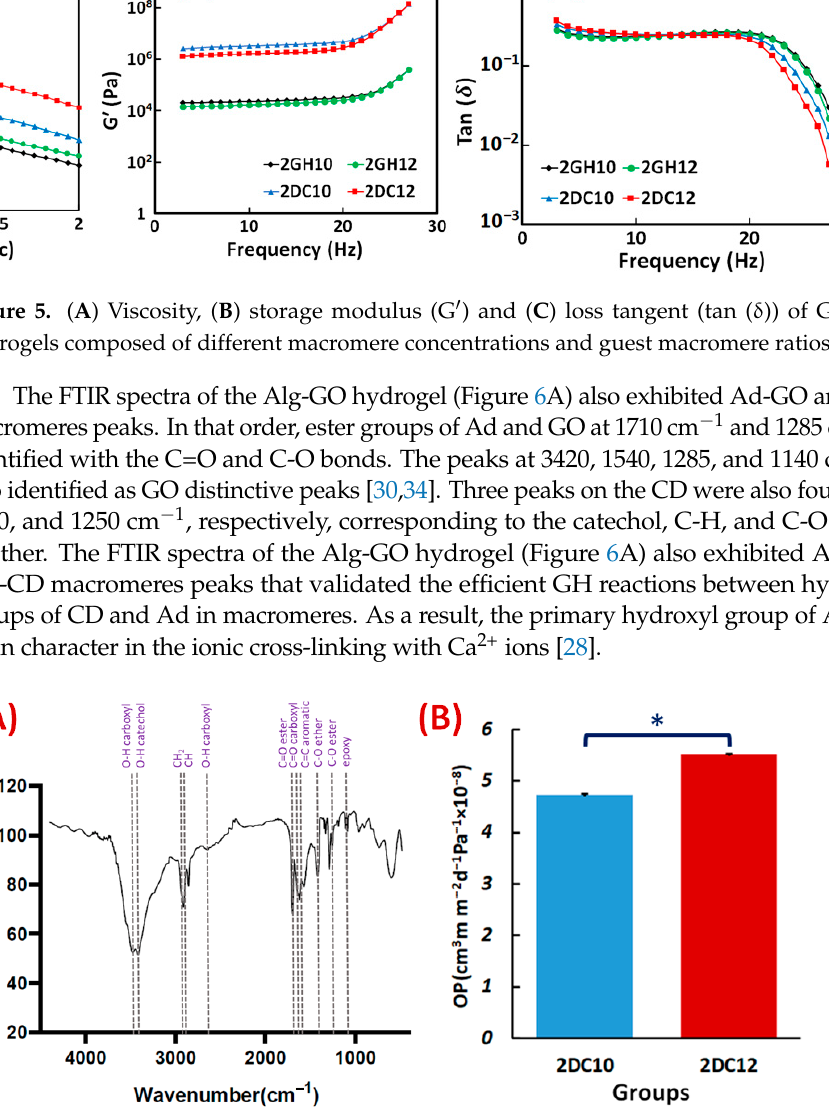
Figure 6. Characterisation of Alg-GO hydrogel: ( A ) FTIR spectrum of Alg-GO (2DC12) hydrogel. ( B ) The OP properties of 2DC10, and 2DC12 hydrogels ( n = 3) (* p < 0.05).